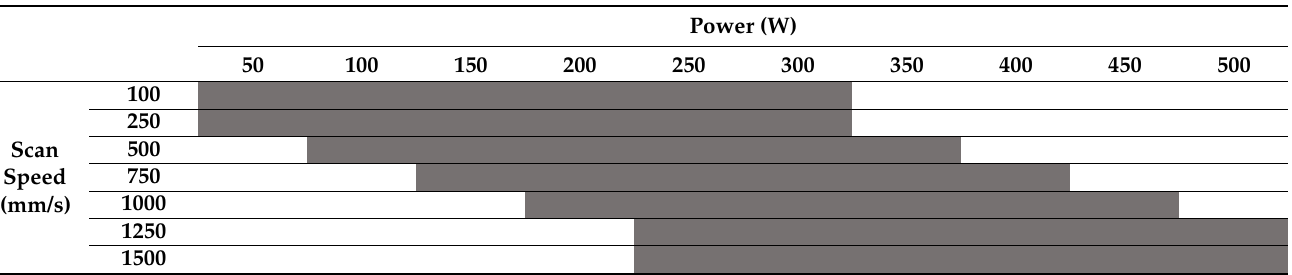
Table 1. Laser-scanning parameter matrix. Cells highlighted in gray indicate laser power–scan speed combinations that were applied in this